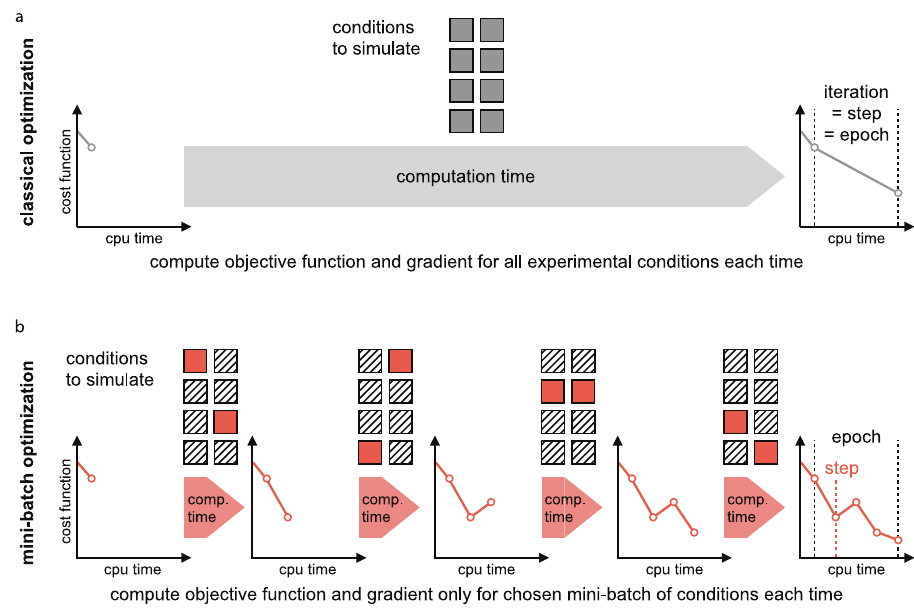
Fig. 1 Visualization of full-batch and mini-batch optimization. a Classic full-batch optimization methods evaluate the contribution of all data points — and thus all experimental conditions — to the objective function in each step. The computation time scales linearly with the number of independently evaluable experimental conditions (depicted as gray squares). b In mini-batch optimization, the independent experimental conditions are randomly divided into disjoint subsets, the mini-batches (depicted as squares). Per the optimization step, only the contribution of the chosen mini-batch is evaluated (red squares). Hence, possibly many optimization steps can be performed during one epoch, which is the time until the whole dataset has been evaluated. Table 1 Overview of ODE models for benchmarking mini-batch